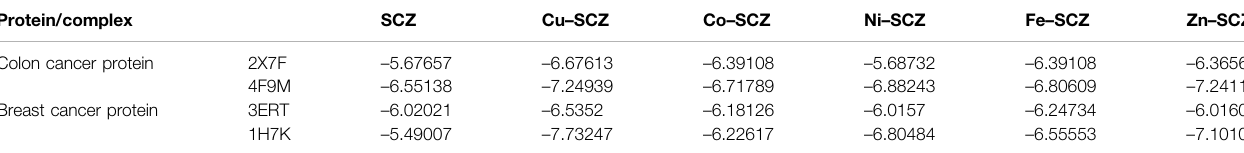
TABLE 4 | Energy score (kcal mol -1 ) calculation for SCZ and its metal complexes toward four protein receptors. Protein/complex SCZ Colon cancer protein Breast cancer